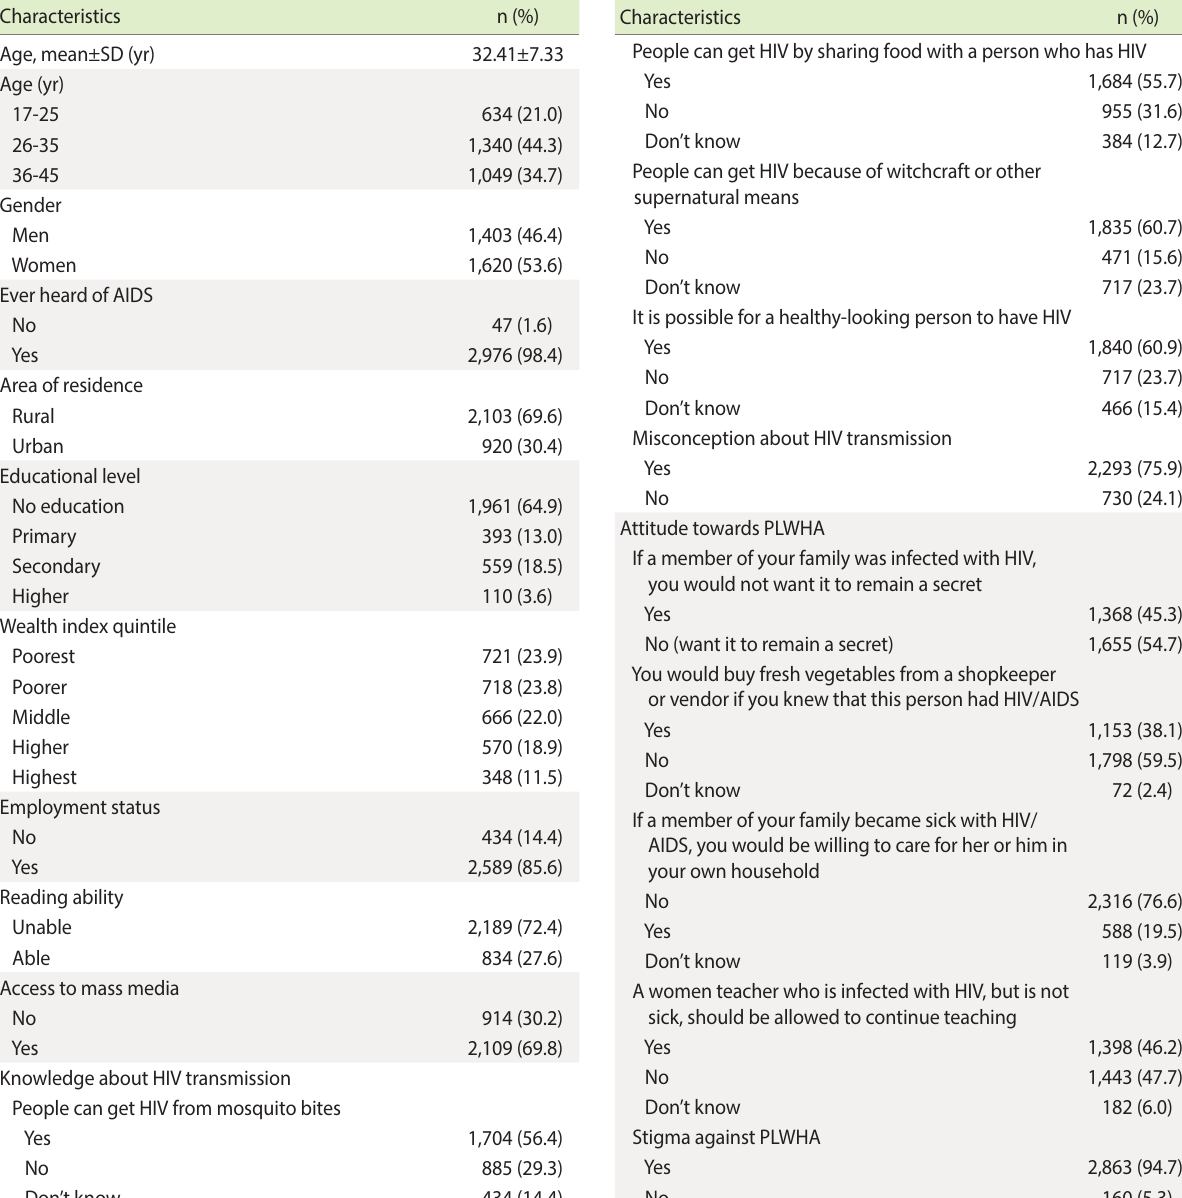
Table 1. Descriptive characteristics of the analytic sample (n=3,023)